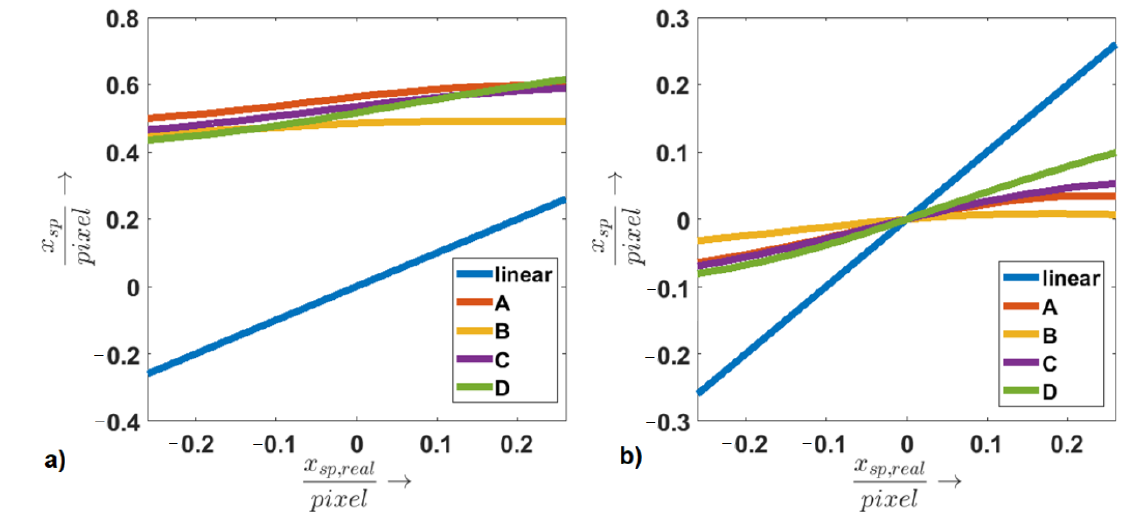
Figure 10. The computed values for x sp are shown over the x sp , real without ( a ) and with zero offset correction ( b